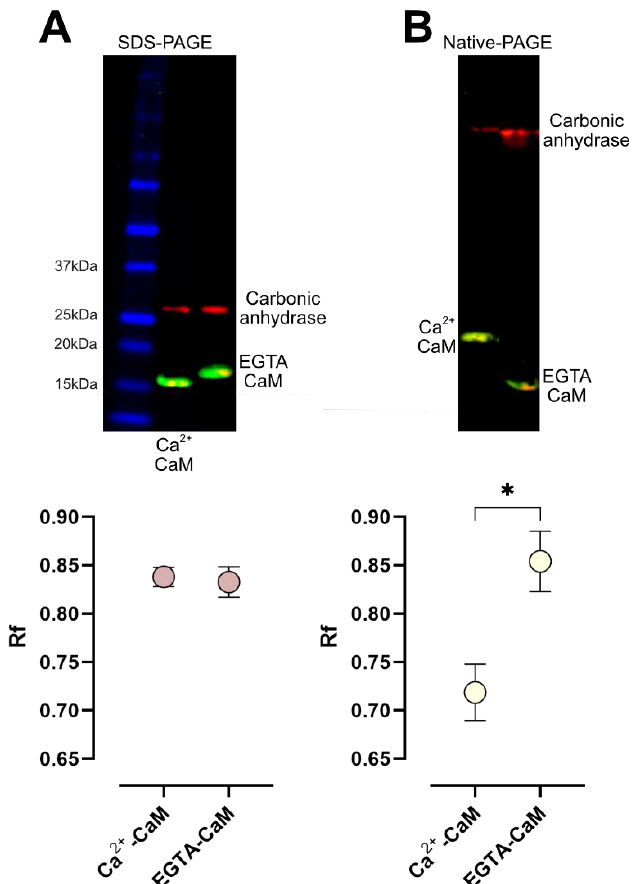
Figure 2. Effect of Ca 2+ and EGTA in the relative mobility of calmodulin. ( A ) SDS-PAGE of calmodulin (CaM) pre-incubated with either Ca 2+ or EGTA. ( B ) Native-PAGE of CaM pre-incubated with either Ca 2+ or EGTA. In both cases, carbonic anhydrase was included as external loading control. Spot graphs show the relative mobility (mean, SEM) of the denatured (SDS-PAGE) or the native (Native-PAGE) CaM. Data of 3 independent experiments were analyzed with a two-sample t test, * p < 0.05.